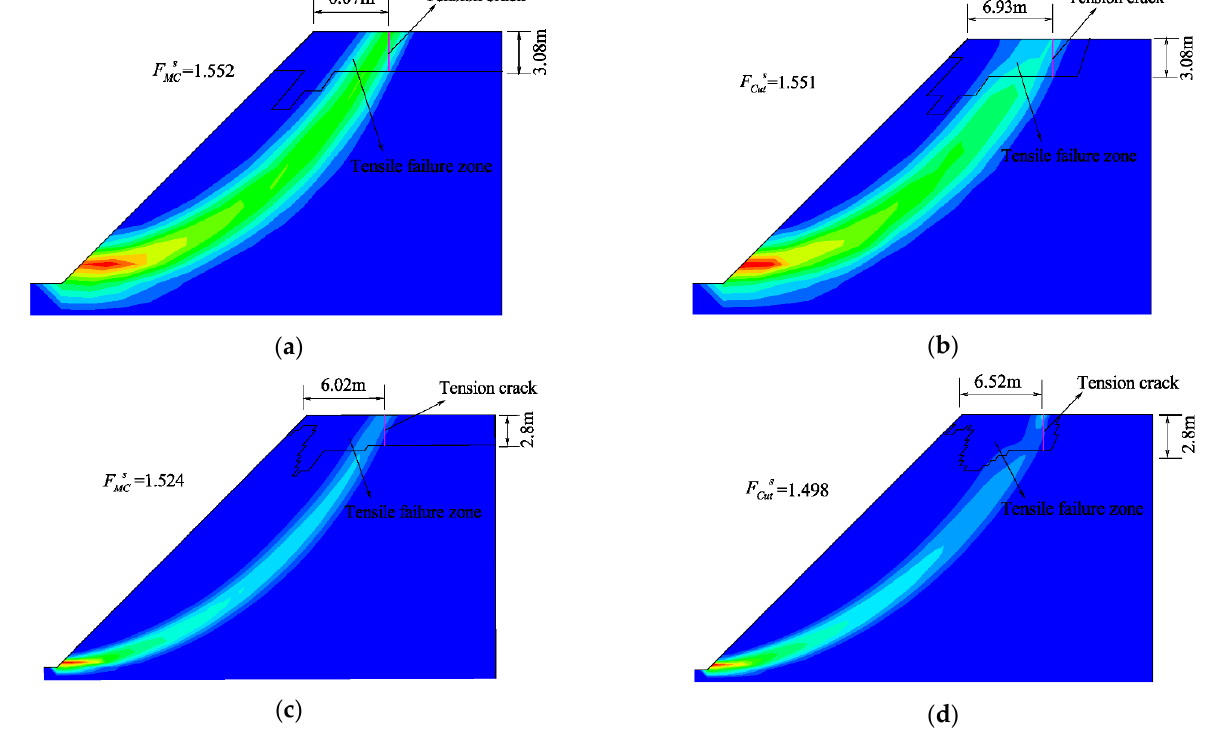
Figure 6. Influence of mesh density. ( a ) failure mechanisms of intact M–C surface with 395 elements; ( b ) failure mechanisms of the cut-off M–C surface with 395 elements; ( c ) failure mechanisms of intact M–C surface with 6000 elements; ( d ) failure mechanisms of the cut-off M–C surface with 6000 elements.